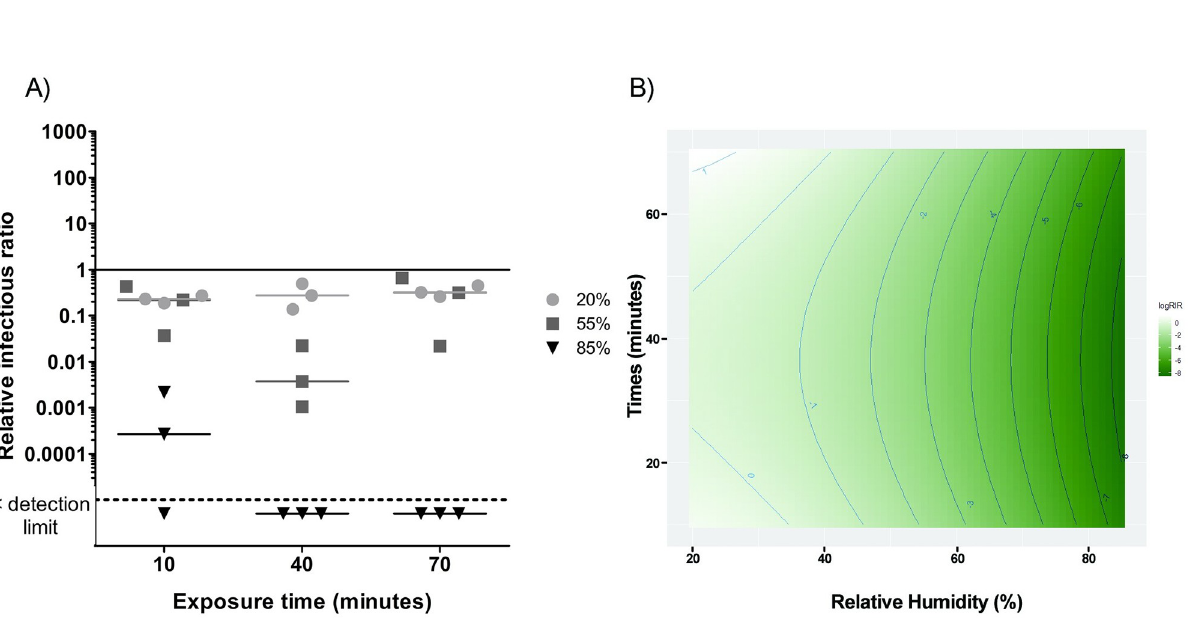
Fig 3. A) Ozone effect on phage φ X174 infectivity at three levels of relative humidity and three exposure times. The solid line represents the reference value without ozone. The dotted line represents the detection limit. 20% RH values are represented by circles ( ● ), 55% RH by squares ( ■ ) and 85% RH by triangles ( ▼ ). B) RSM between exposure time and humidity percentages for φ X174. The darker the green colour, the greater the inactivation related to relative humidity and time